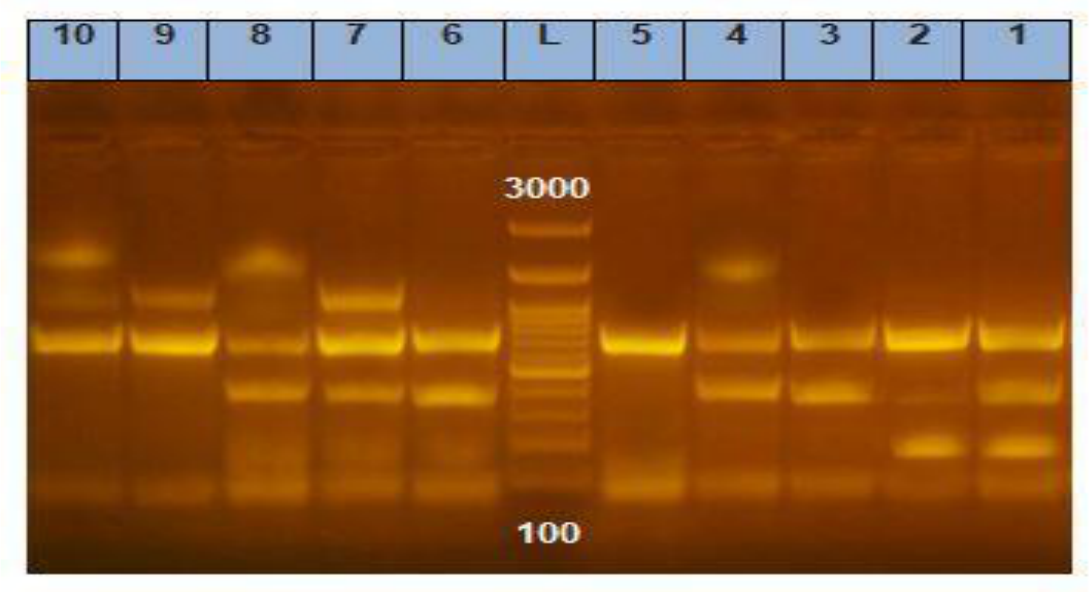
Figure 3. DNA fingerprinting of ERIC-PCR of K. pneumoniae isolates. Note: L: lane 100:3000 bp DNA ladder; lane 1 to 10: K. pneumoniae isolates.